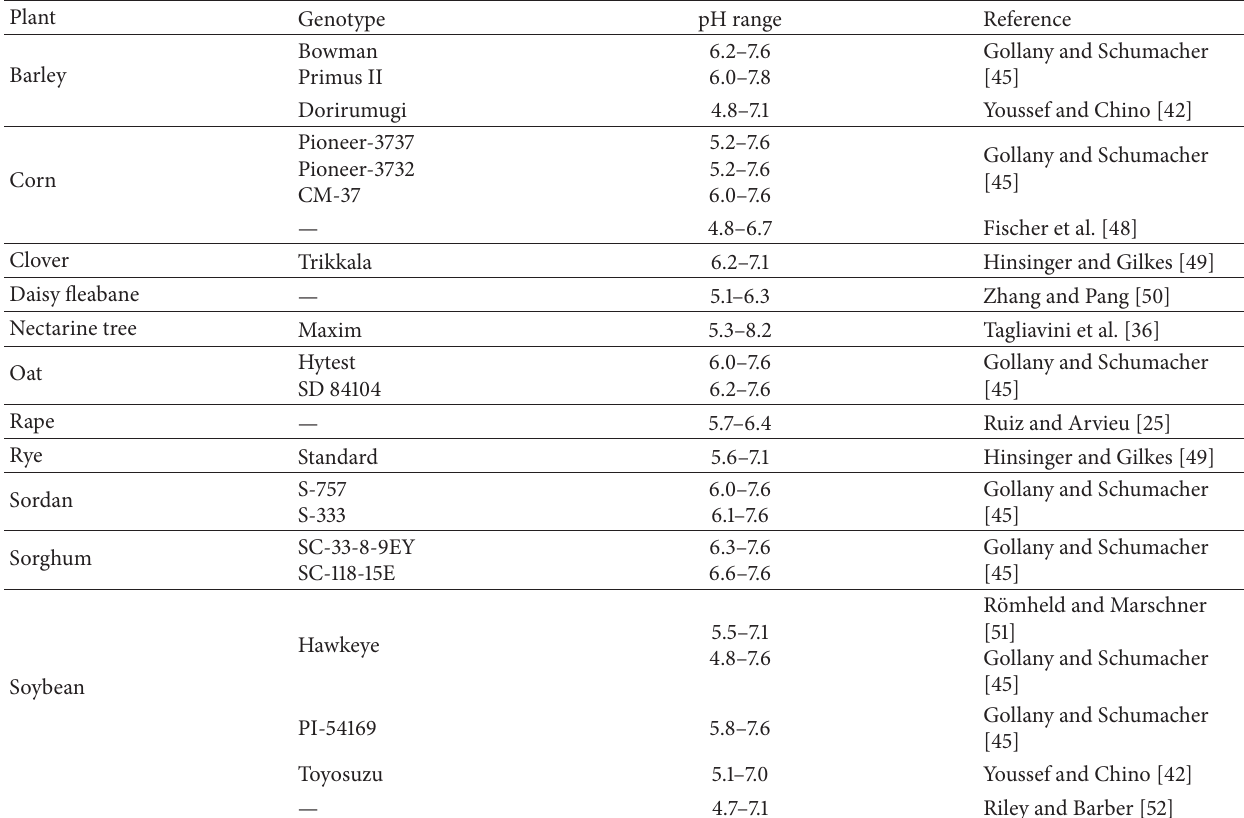
Table 5: Reported pH ranges of